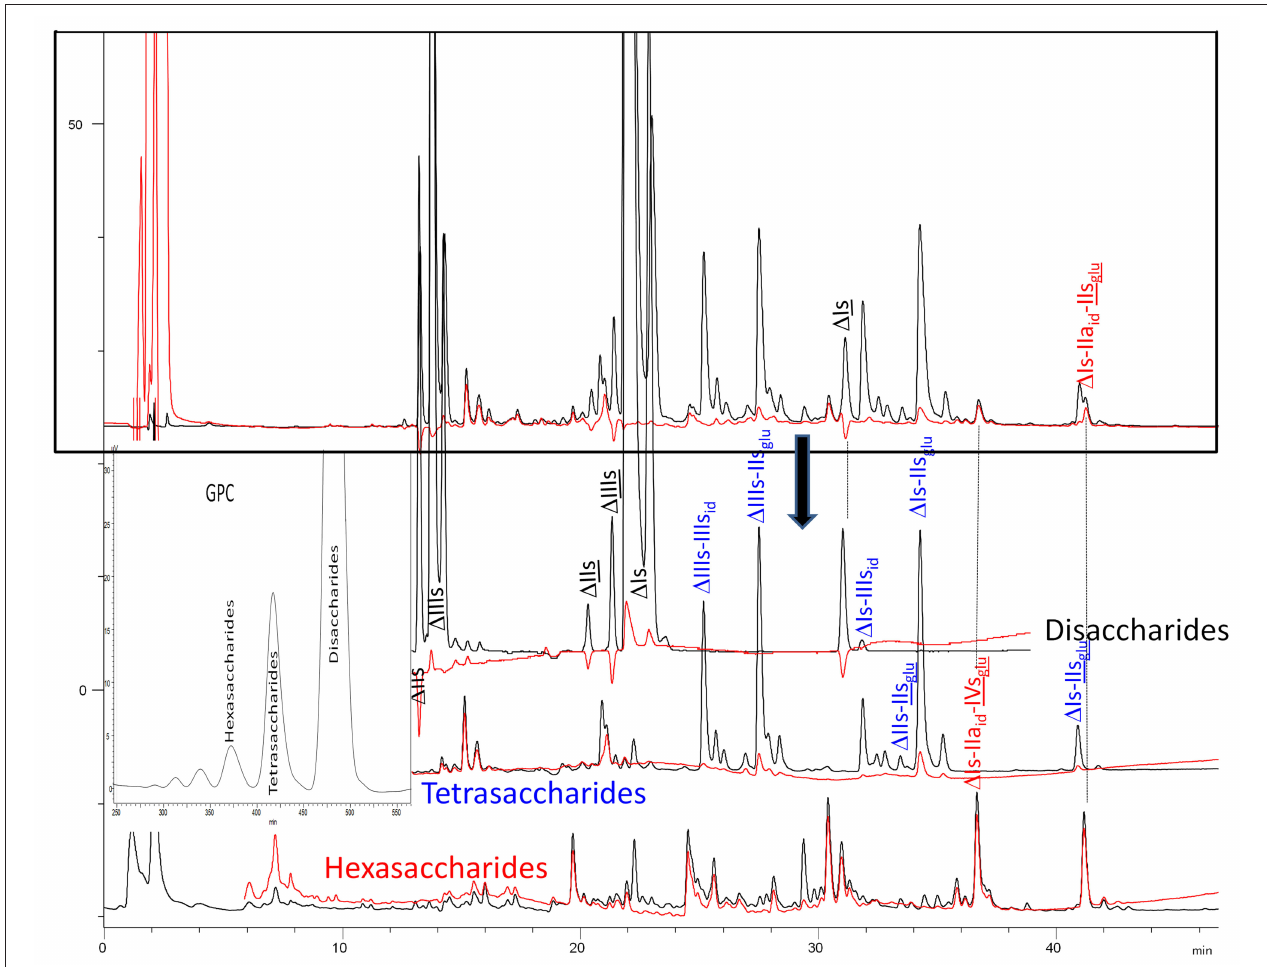
FIGURE 2 | Heparinase I digest of bovine intestine heparin (BMH) separated on a Carbopack AS11 column. Disaccharides to hexasaccharides are the gel permeation chromatography fractions corresponding to the digest. Black line ( — ): UV 232nm; red line ( — ): UV 202